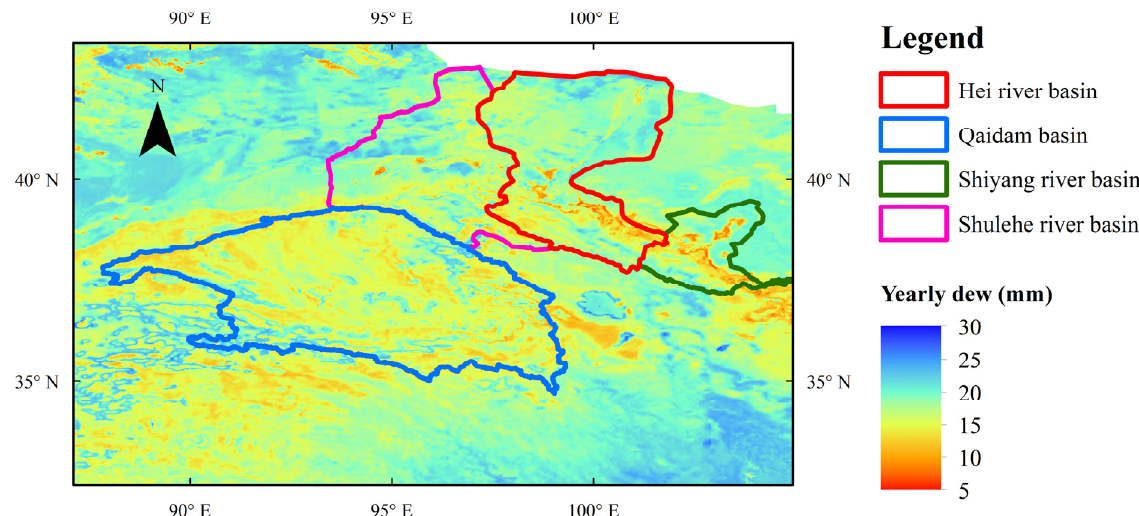
Figure 14. Average annual condensation water distribution from 2011 to 2020 in northwest China.